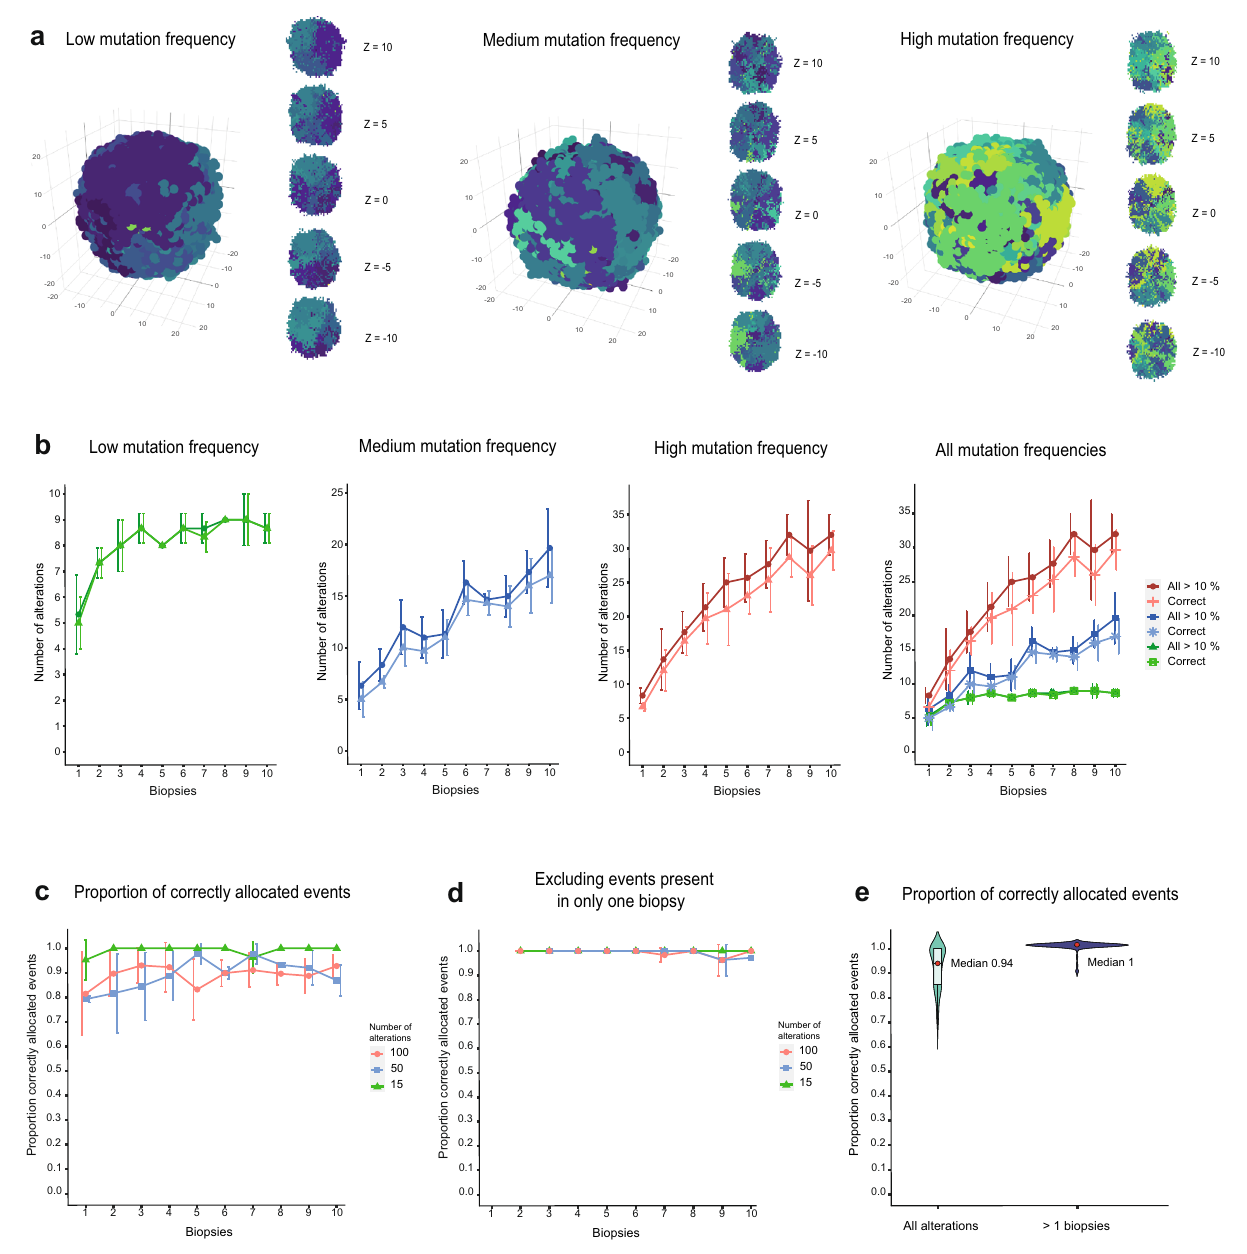
Fig. 4 Properties of the simulated bulk genotyping data set along with the performance measure of DEVOLUTION. a Visualization of three simulated tumors with increasing mutation frequency. To the right of each tumor are cross-sections at fi ve positions (z). Each color represents a subclone harboring a unique genetic pro fi le. b When increasing the number of biopsies, more genetic alterations and hence subclones, are identi fi ed. In addition, the algorithm is also able to identify more subclones correctly. Each point in the graph is the mean of three consecutive measurements and the error bars consequently the standard deviation. c The proportion of genetic alterations correctly allocated ± 1 SD when increasing the number of biopsies from 1 to 10 for three different mutation frequencies resulting in 10 (green), 50 (blue), and 100 (red) genetic alterations present in the virtual tumor. Each point is the mean of three iterations. d The proportion of correctly allocated genetic alterations when excluding genetic alterations that were only found in a single biopsy. e Violin plot showing the spread of the proportion of correctly allocated genetic alterations when including all alterations and when excluding the genetic alterations only found in one biopsy. The box plots within the violin plots illustrates the interquartile range. The red dot is the median value. The information used to produce the plots can be found in Supplementary Data 3 and